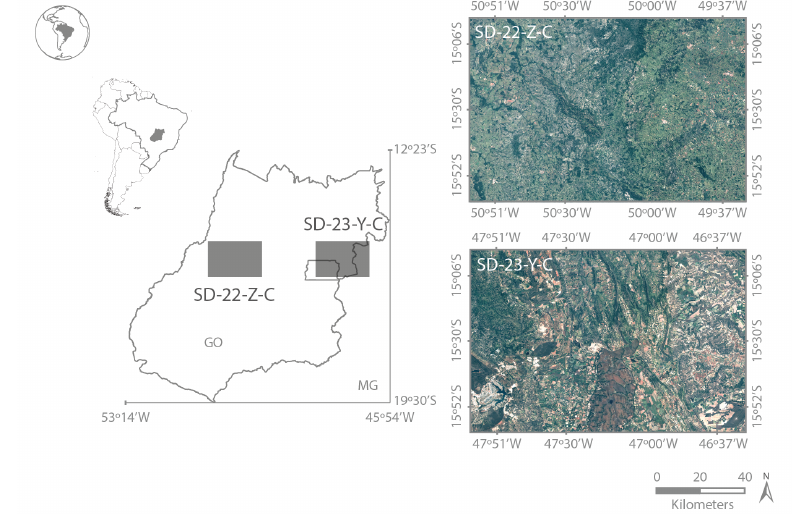
Figure 1. Spatial location of grids SD-23-Y-C and